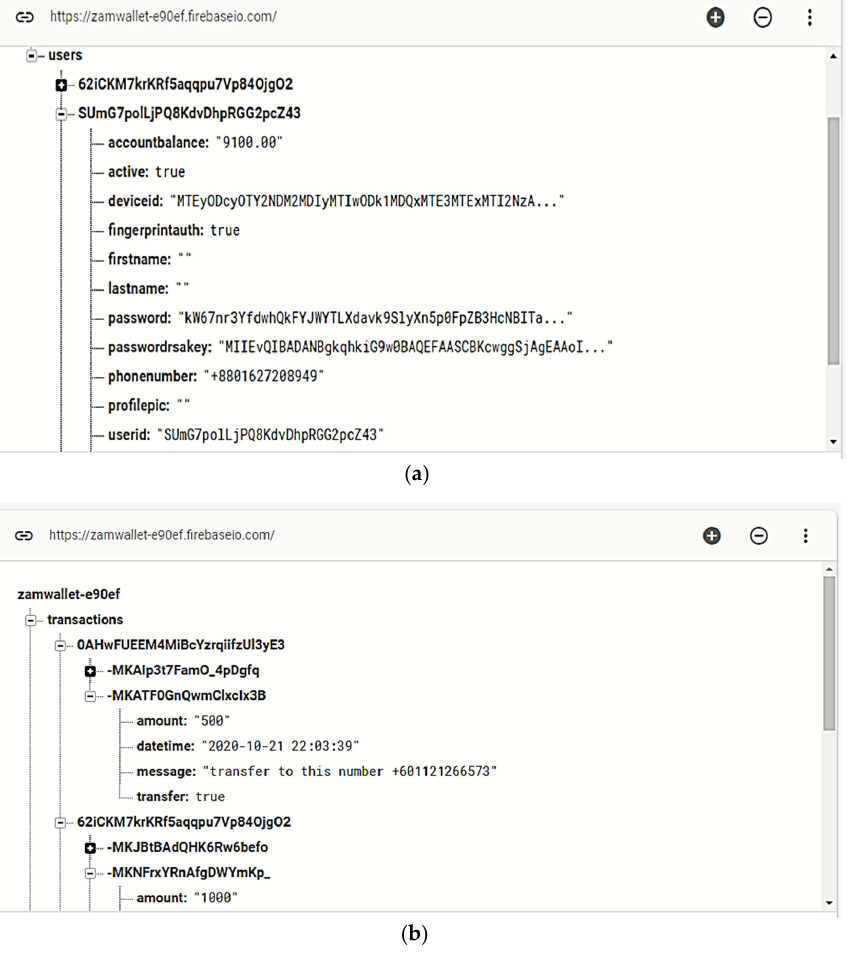
Figure 17. Overview of real-time database activities. ( a ): User information on Firebase database and ( b ): user transaction details on Firebase database.